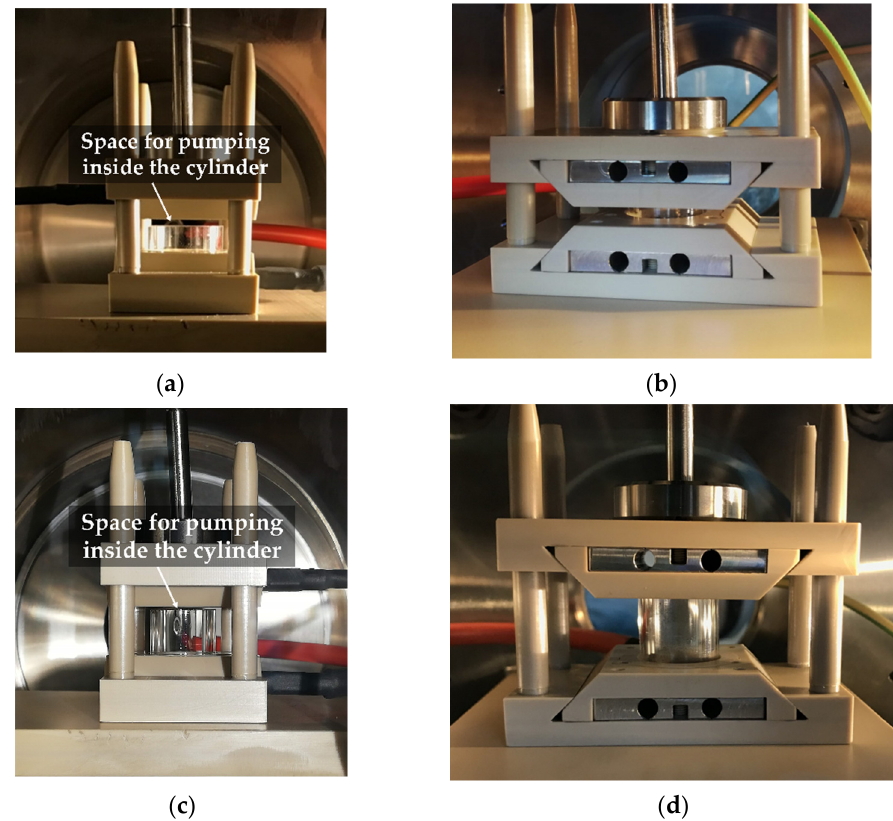
Figure 5. Open and closed cylinder with heights of 1 cm ( a ) and ( b ), and 2 cm ( c ) and ( d ).